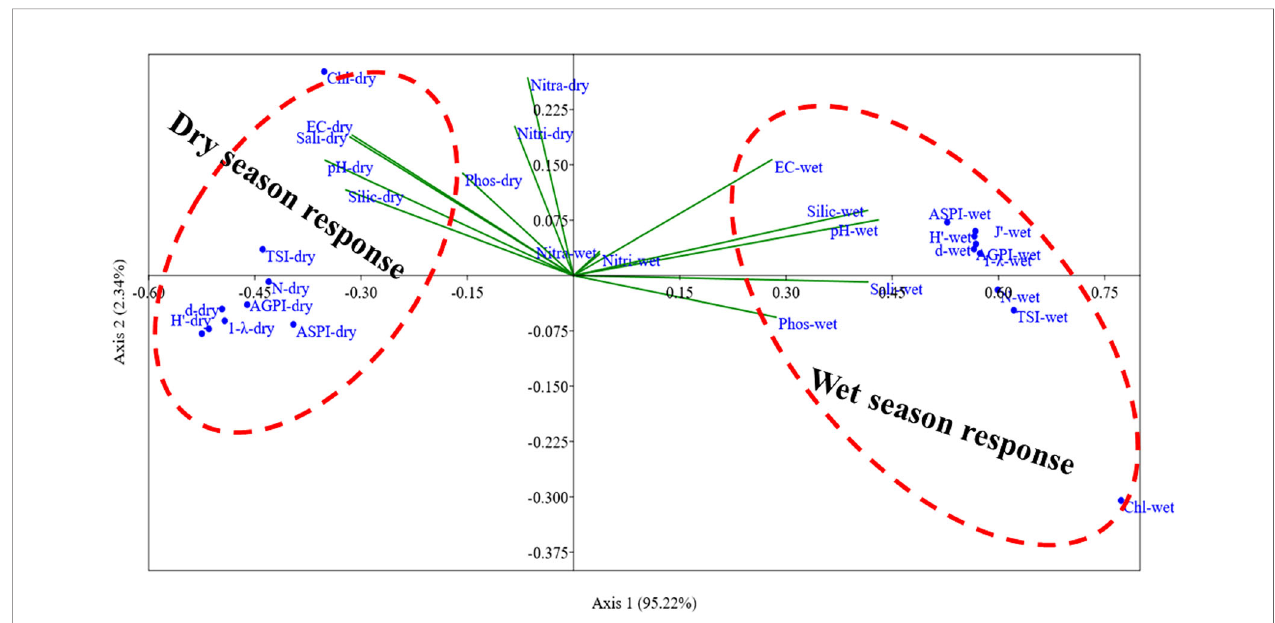
FIGURE 8 | CCA ordination showing the response relationship of the biodiversity indices, trophic state indices, and environmental variables in the mangrove ecosystem during dry and wet seasons. (N, algal abundance; d , Margalef index; J ′ , Pielou index; H ′ , Shannon – Weaver index; 1 − l , Simpson index; AGPI, Algal genus pollution index; ASPI, Algal species pollution index; EC, Electrical conductivity; Sali, salinity; Chl, Chlorophyll- a ; Nitra, Nitrate; Nitri, Nitrite; Phos, phosphate; Silic,